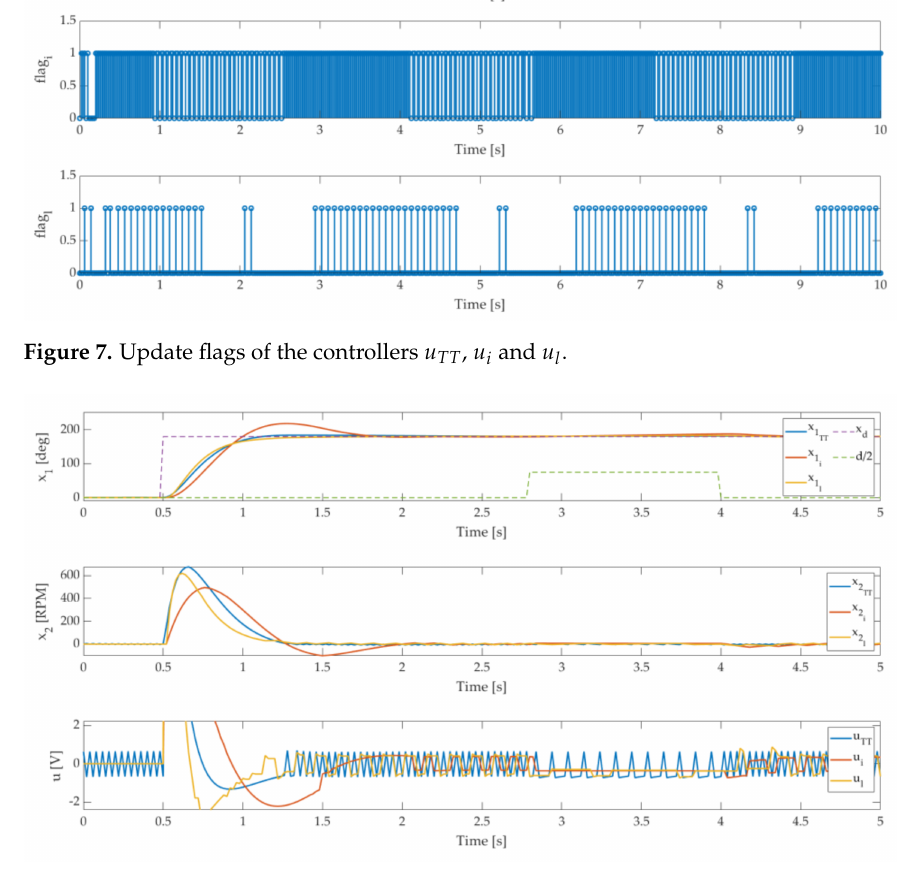
Figure 8. Disturbance rejection of u TT , u i and u l